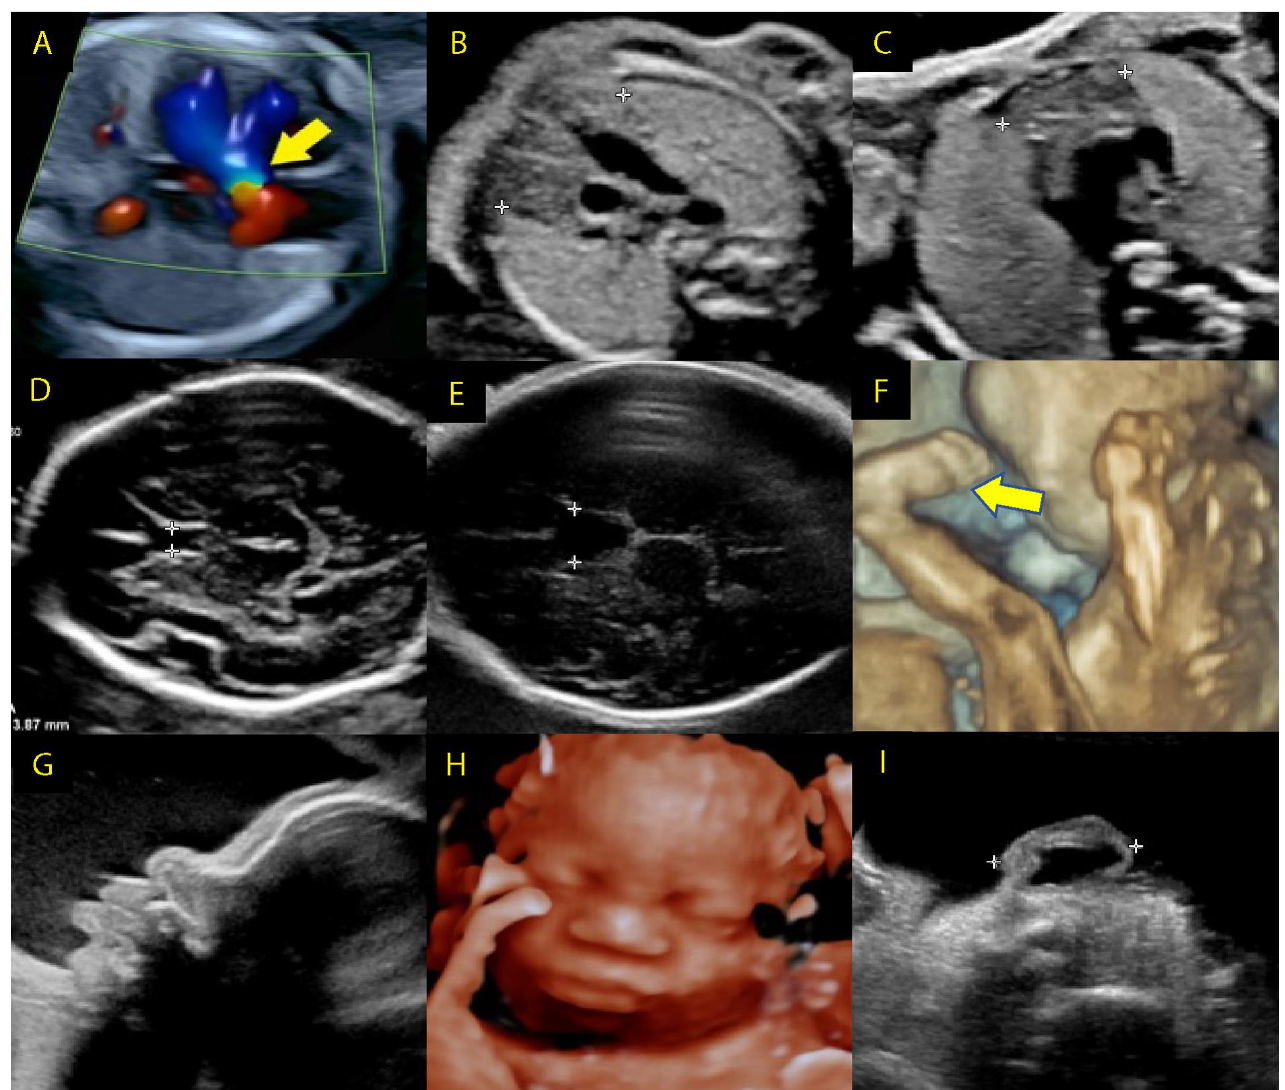
Figure 5. Second- and third-trimester ultrasound findings in 22q11.2DS. ( A ) Tetralogy of Fallot, overriding aorta (arrow), ( B ) normal thymus, ( C ) hypoplastic thymus, ( D ) normal cavum septi pellucidi (CSP), ( E ) enlarged CSP, ( F ) talipes equinovarus (arrow), ( G ) profile with bulbous nose, ( H ) face with bulbous nose, ( I ) small ear with thickened overfolded helix. ( B through E —areas of interest are indicated by